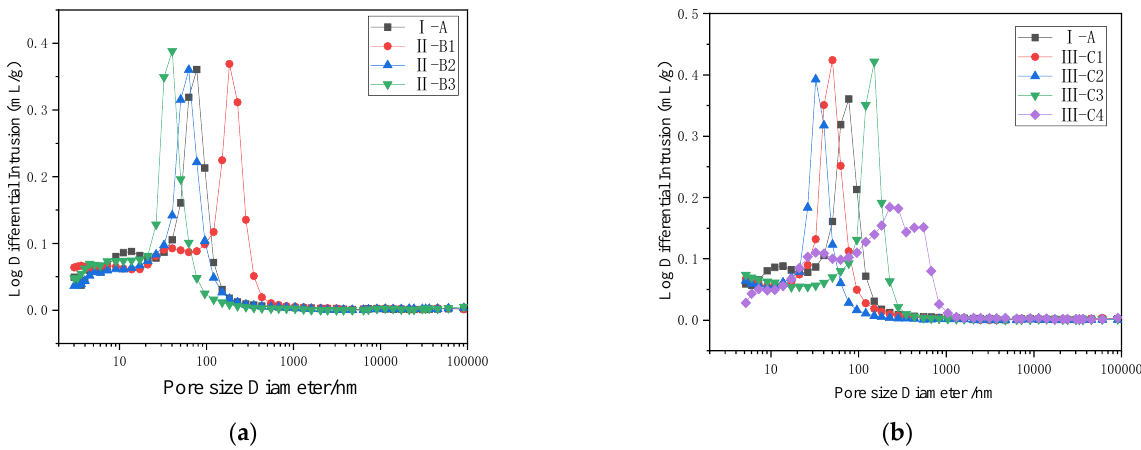
Figure 4. Effect of composite premature strength internal maintenance material on 7-day pore size distribution of pure cement paste: ( a ) single early-age strength component; ( b ) compound early-age strength components. Table 4. Effect of composite premature strength inner sample guard material.